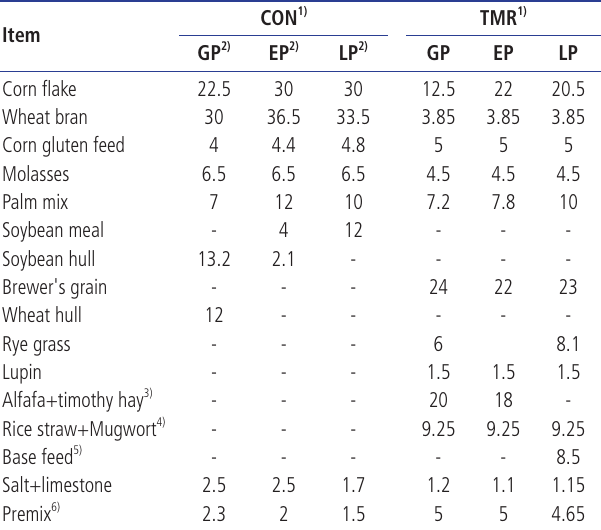
Table 1. Ingredient composition of experimental diets